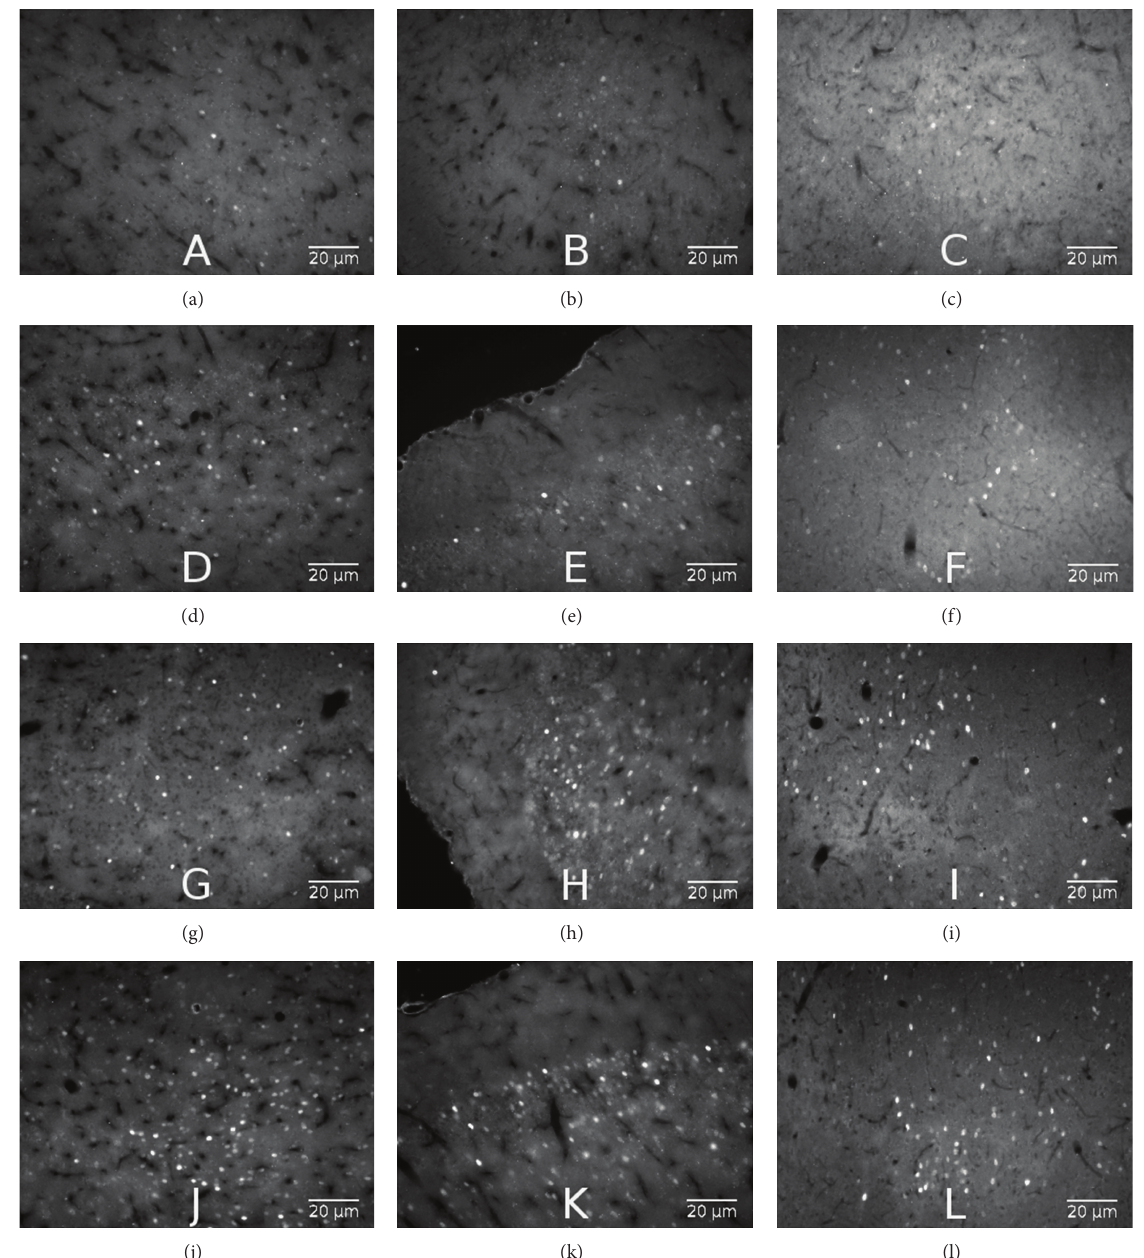
Figure 3: Immunofluorescence staining of nuclear c-Fos in the neurons of the olfactory bulb (a, d, g, and j), piriform cortex (b, e, h, and k), and periaqueductal gray (c, f, i, and l) 90 minutes after X. laevigata leaf essential oil (EOX) intraperitoneal injection at doses of 0 (saline control), 12.5, 25, and 50 mg/Kg, respectively, on these three brain regions of the animals submitted to carrageenan hypernociception